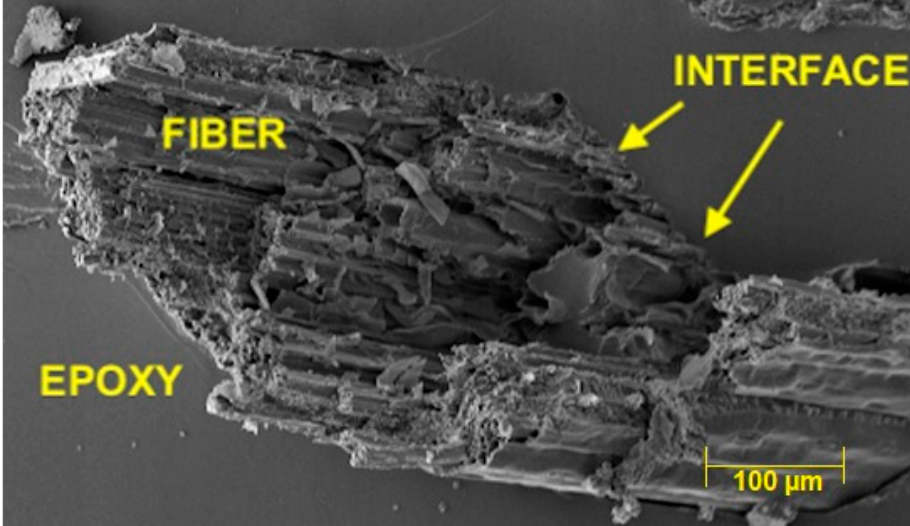
Figure 8. Micrograph of the fracture surface of a sedge fiber embedded in epoxy matrix.